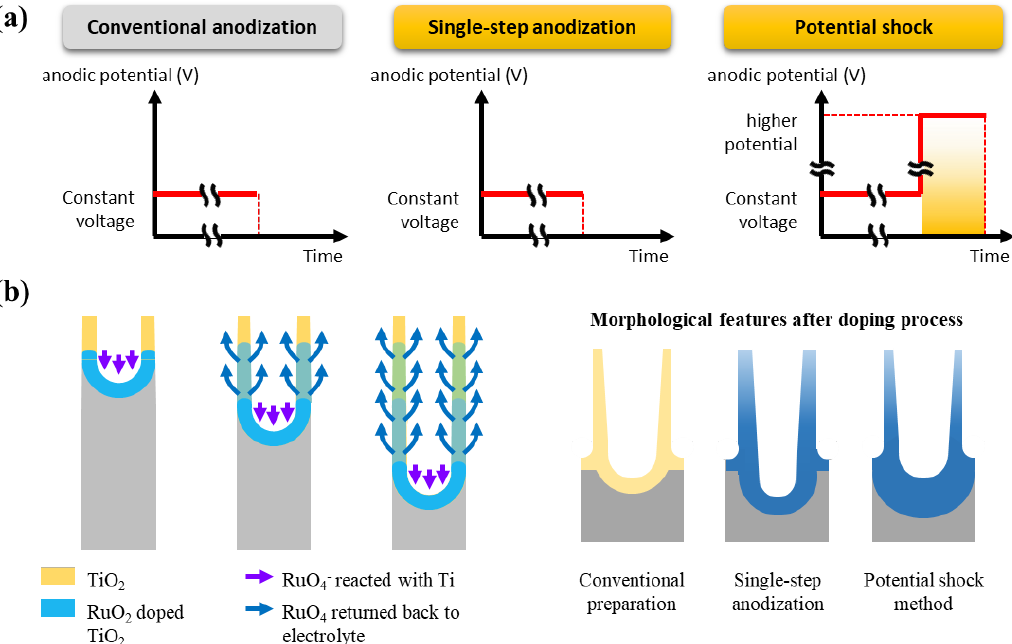
Figure 3. ( a ) A schematic of the conventional anodization procedure and doping methods. Note that potential shock is a sequential two-step anodic process. ( b ) Left: The doping of the catalysts follows “plastic flow.” The doped catalysts are able to partially dissolve at long doping times, as the high anodic potential induces the oxygen evolution reaction. Right: The morphologies of the doped TiO 2 nanotubes depends on the doping method. Reproduced with permission from ref [31]. Inha University (2018).